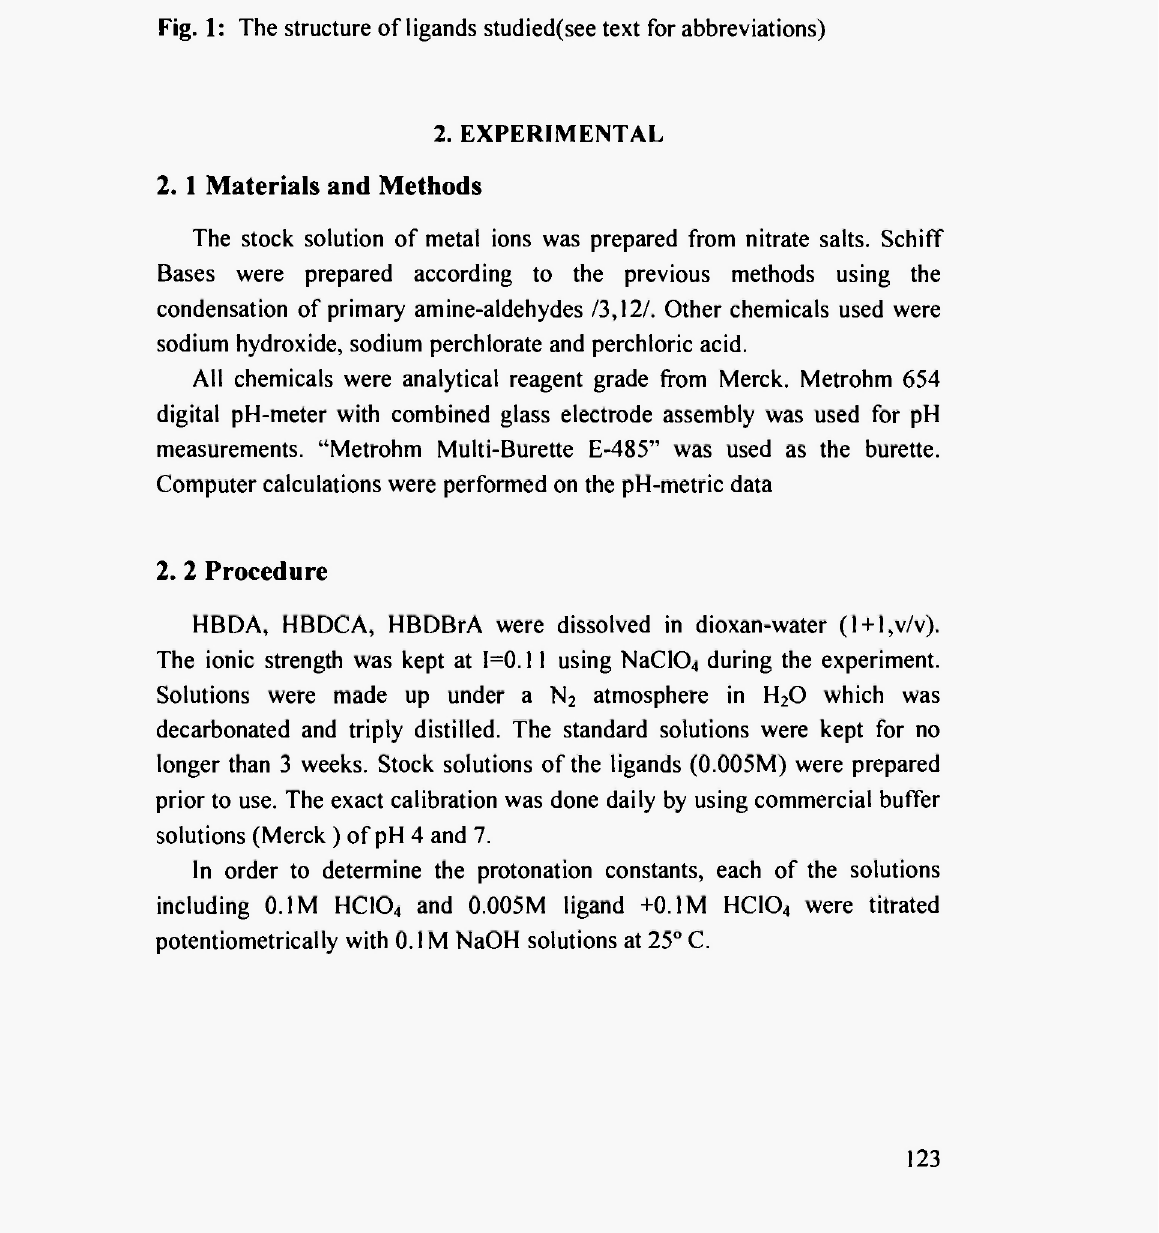
Fig. 1: The structure of ligands studied(see text for